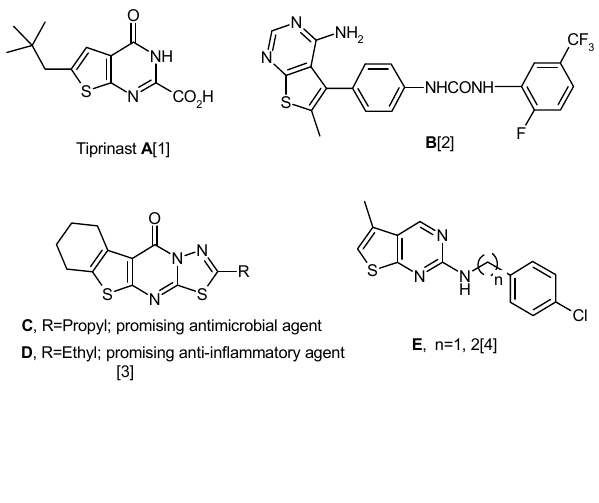
Figure 1. Some biologically active